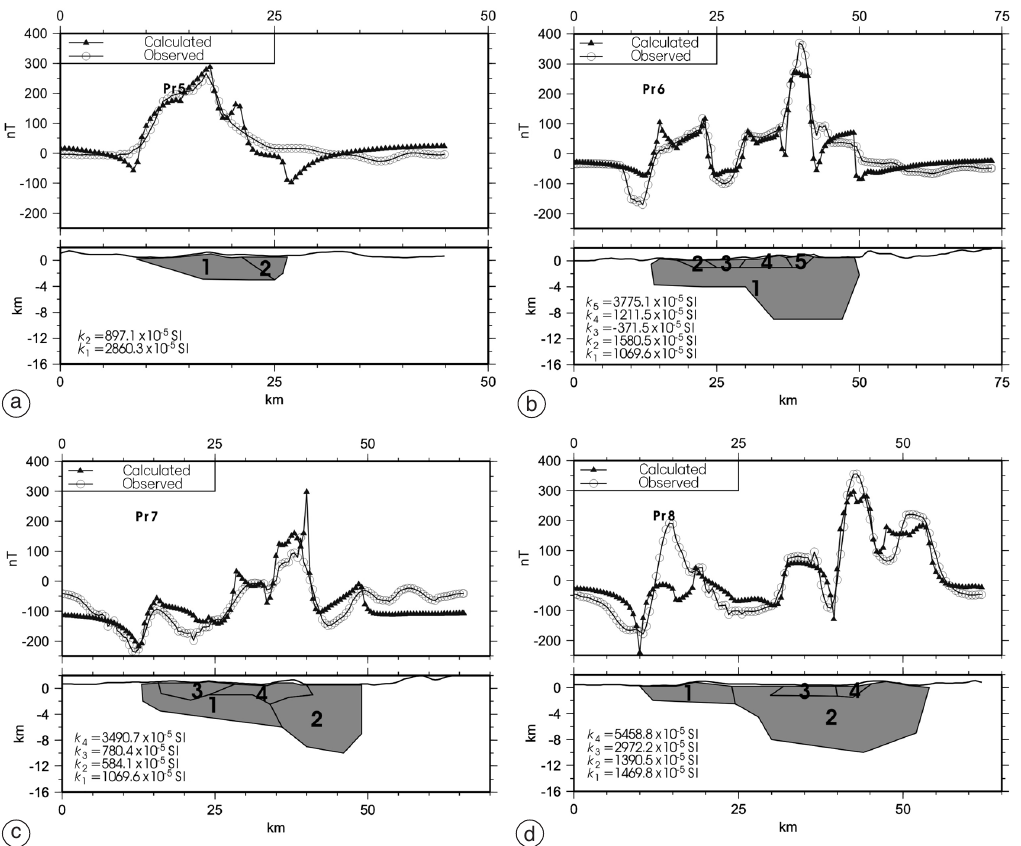
Fig. 12a-d. 2.5D modeling of the magnetic sources along the profiles Pr5 (a), Pr6 (b), Pr7 (c) and Pr8 (d) (see fig. 2 for the location of